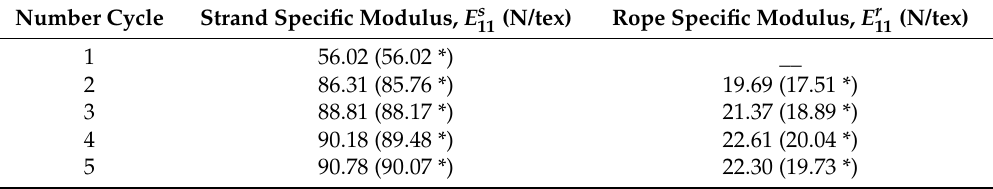
Figure 6. Loading portion of the rope under five cyclic loadings. Table 3. Longitudinal specific modulus of strand and rope at the loading portion for five